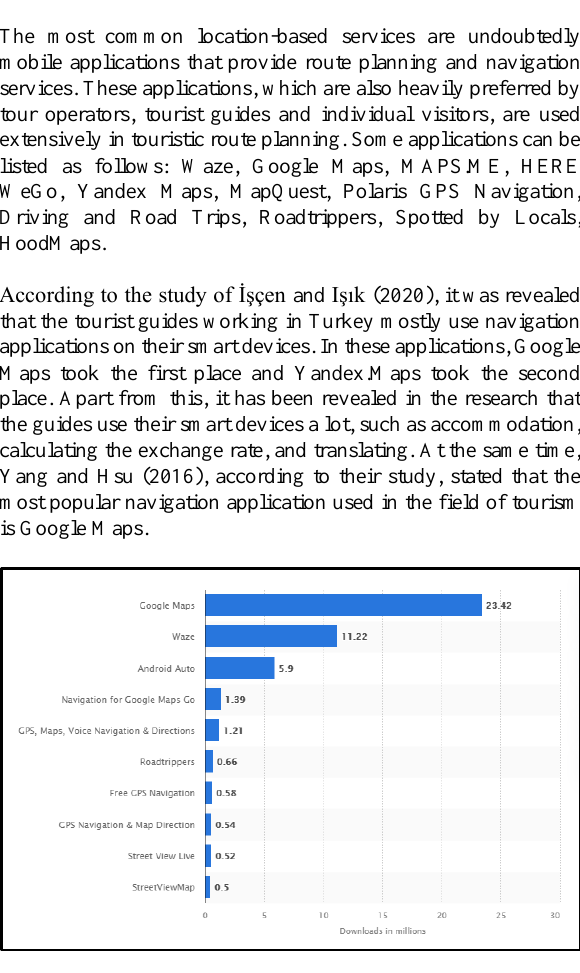
Figure 1: Leading map apps in the United States in 2020 by downloads in millions (Statista,